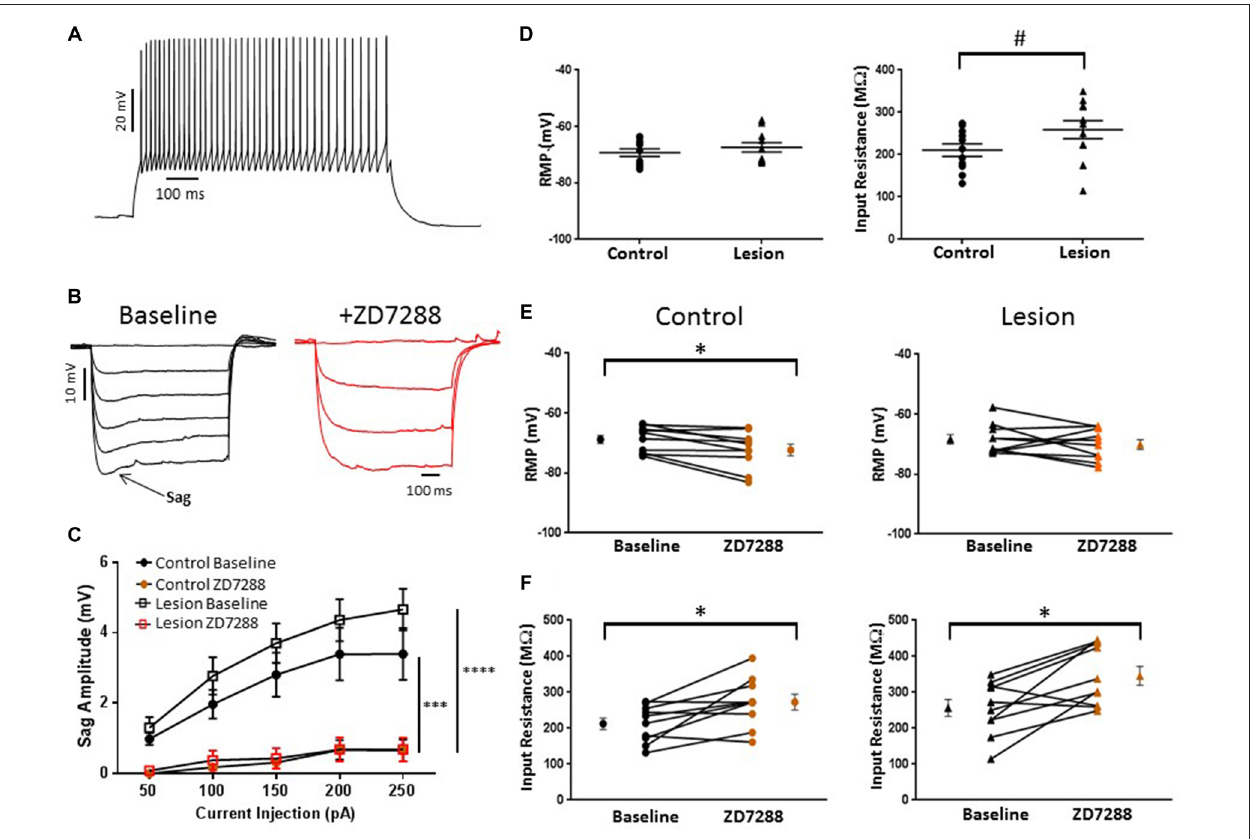
FIGURE 5 | HCN channel blockade significantly alters the intrinsic properties of accommodating interneurons in control animals. (A) Typical spiking response from a L5 accommodating interneuron. (B) Typical voltage “sag” (arrow) in response to hyperpolarizing current pulses from control animals before (black trace) and after (red trace) administration of ZD7288. The first three − 50 pA current steps are shown following ZD7288 application. Sag response was blocked in the presence of the HCN channel antagonist. (C) Quantification of voltage sag amplitudes before and after ZD7288 for control ( n = 10, 2-way ANOVA, p < 0.001) and lesion ( n = 11, 2-way ANOVA, p < 0.0001) groups. (D) RMP (left) and input resistance (right) for control and freeze lesion groups at baseline (Control: n = 11, Lesion: n = 11). (E) Blockade of HCN channels significantly hyperpolarized cells from control (left; n = 10) but not lesion groups (right; n = 10). (F) The input resistance of interneurons from both control (left; n = 10) and lesion groups (right; n = 10) was significantly increased following ZD7288 application. ∗ p < 0.05, paired t -test; # p < 0.05 t -test. Error bars are mean ± SEM. ∗∗∗ Indicates p < 0.01; ∗∗∗∗ p <